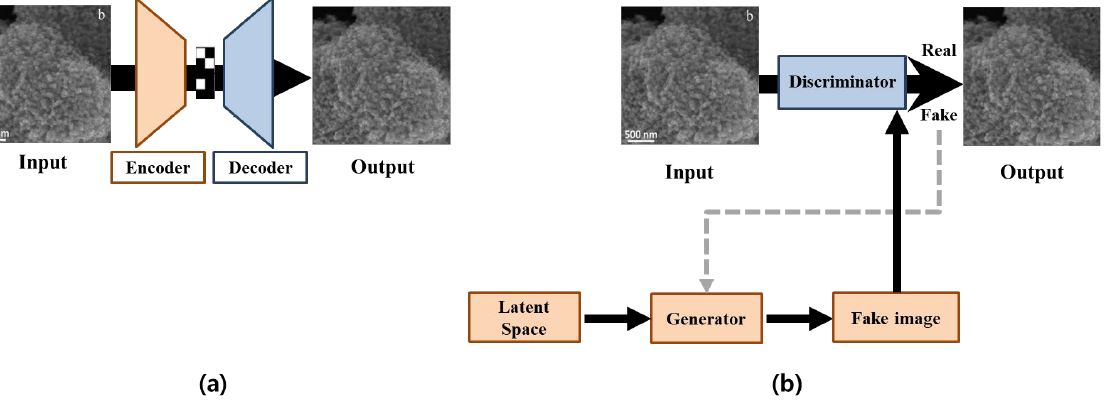
Figure 2. Architectures of deep learning methods (In the figures, input images are the example of the microscopic images in the reprinted with permission from Ref. [14] . Copyright (2019) Elsevier. ) : the microscopic images in the reprinted with permission from Ref. [14]. Copyright (2019) Elsevier.): ( a ) represents the CNN - based method and ( b ) represents the GAN -based method. ( a ) represents the CNN-based method and ( b ) represents the GAN-based